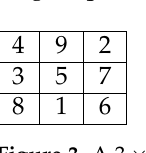
Figure 3. A 3 × 3 magic